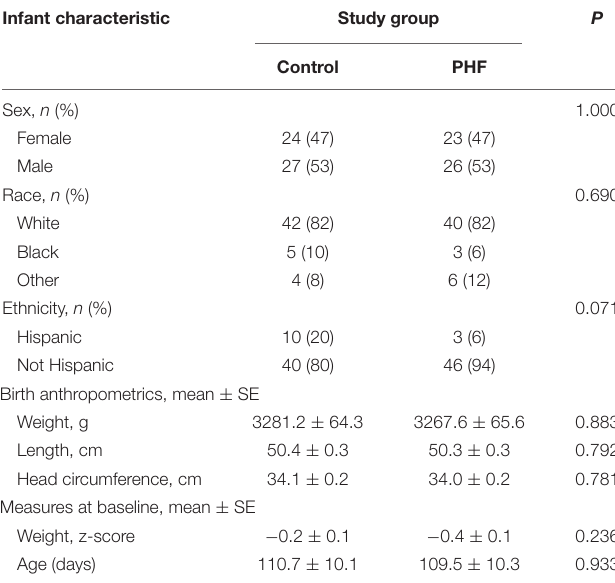
TABLE 3 | Infant characteristics at birth and study baseline.